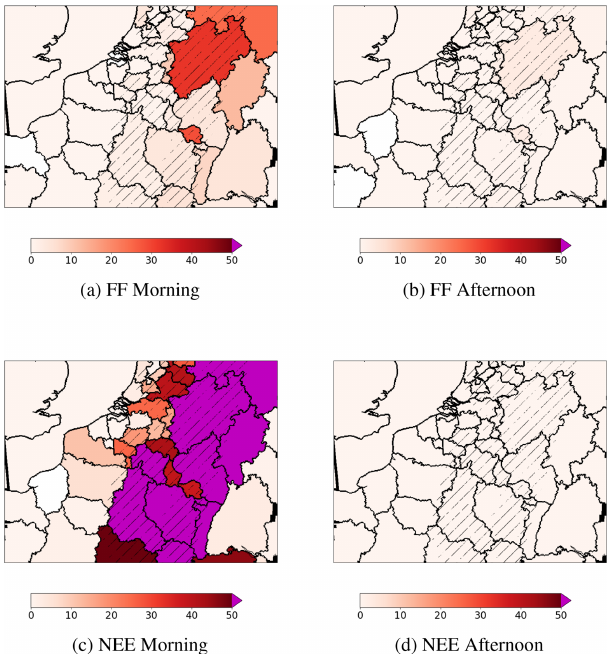
Figure 9. Uncertainty reduction in INV-Sat inversion: for morning (a, c) or afternoon (b, d) budgets of FF and biogenic fluxes (NEE). Stripes are indicative of the satellite field of view (see Fig. 6 for the full track).